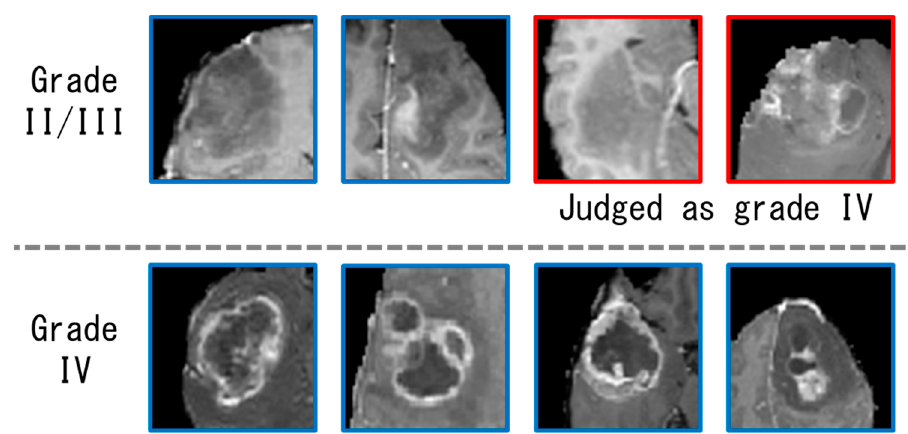
Figure 7. Examples of input images and the corresponding grading result. The blue outlined frames are correctly classified, and the red outlined frames are incorrectly classified.